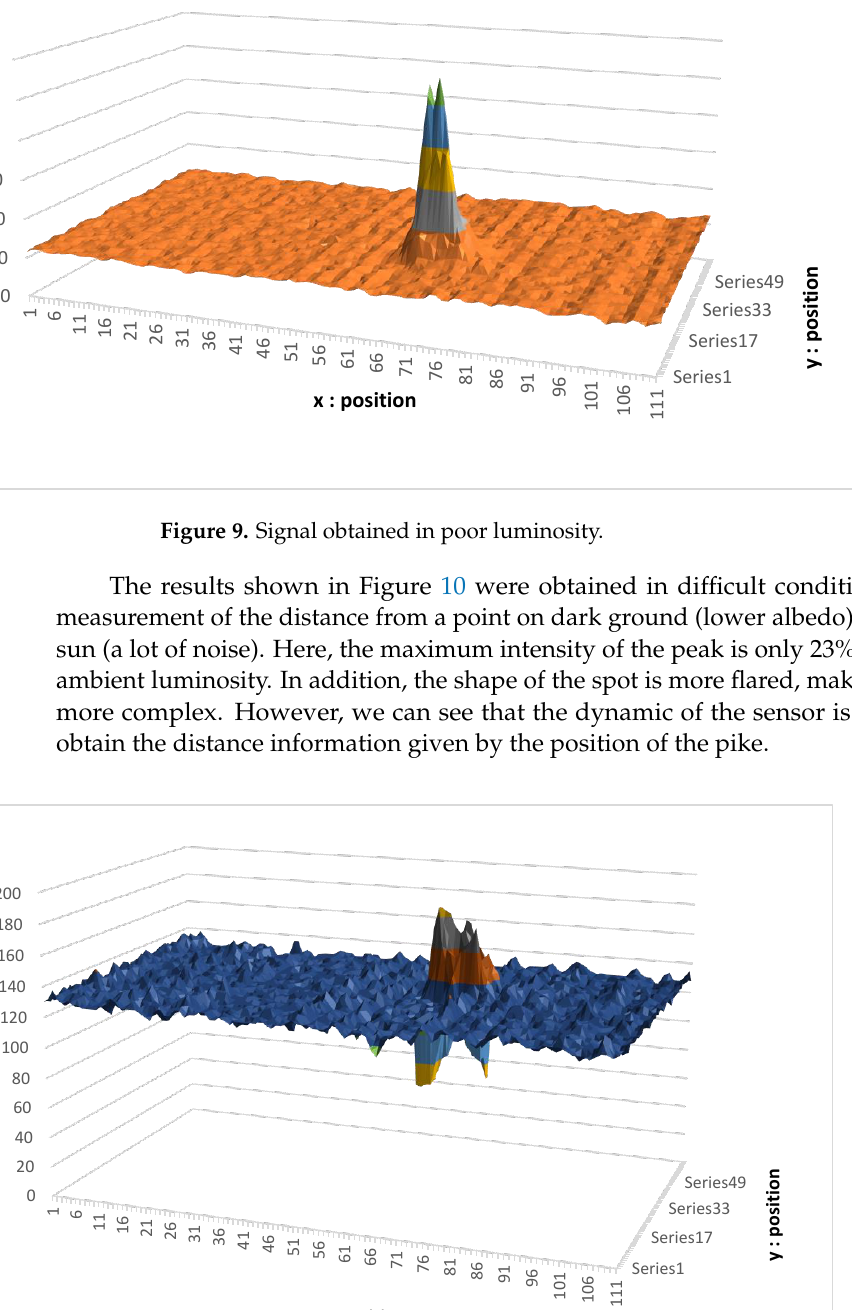
Figure 10. Signal obtained in very high luminosity.